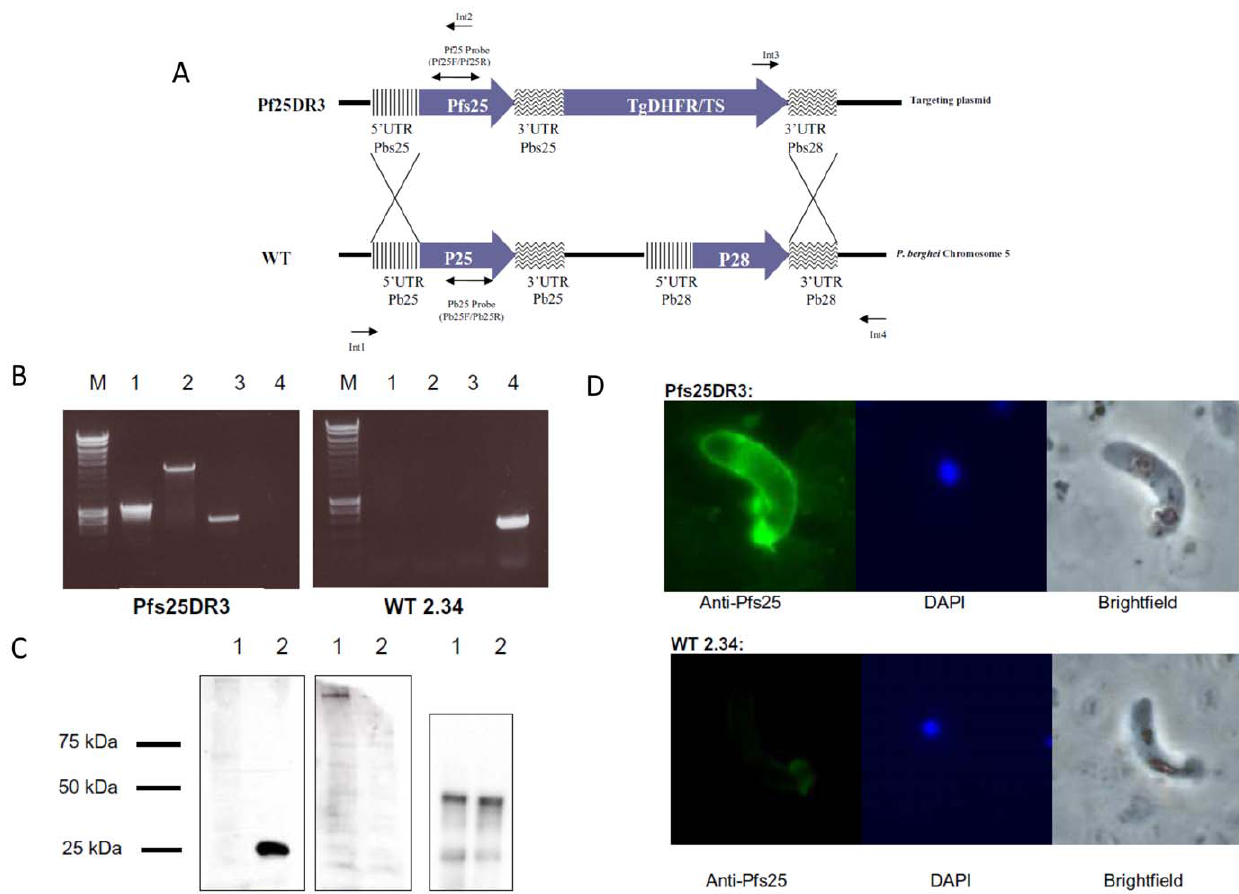
Figure 3. Generation and phenotypic analysis of Pfs25DR3. (A) Schematic representation of the construction of Pfs25DR3. The targeting plasmid was linearized by restriction digestion, and DNA was transfected into P. berghei ANKA 2.34. The P. berghei ORFs P25 and P28 were replaced with the P. falciparum gene sequence of Pfs25 and the selectable marker cassette (TgDHFR/TS). ( B ) Diagnostic PCR on cloned transgenic Pfs25DR3. (M: 500 bp marker; 1: 5 9 integration, oligos Int1 + Int2; 2: 3 9 integration, oligos Int3 + Int4; 3: Pf25 presence, oligos Pf25F + Pf25R; 4: Pb25 presence, oligos Pb25F + Pb25R. (C) Western blot analysis of Pfs25DR3 ookinetes. Purified ookinetes (5 6 10 7 per lane) were hybridized with anti-Pfs25/GFP serum from Ad-MVA immunized mice. Loading control was carried out on stripped nitrocellulose membrane with anti-TAT-1 antibody at 1:10,000 (primary), and anti-mouse IgG at 1:10,000 (secondary). Lane 1: P. berghei WT 2.34 ookinetes; Lane 2: P. berghei Pfs25DR3 ookinetes. (D) Expression and localization of Pfs25 in the Pfs25DR3 transgenic parasite was confirmed via immunofluoresence assay on PFA fixed ookinetes.